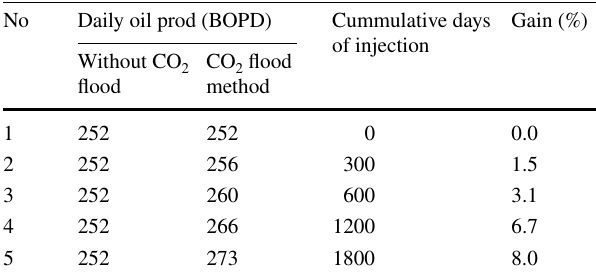
Fig. 3 Effect of oil viscosity due to fraction of dissolved CO cumulative day of injection